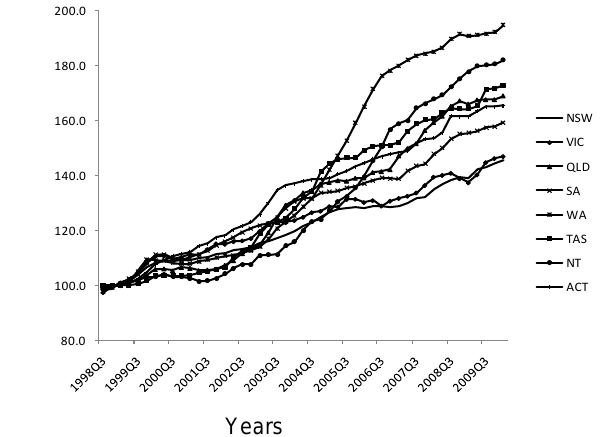
Figure 1: The output PPI of house construction in